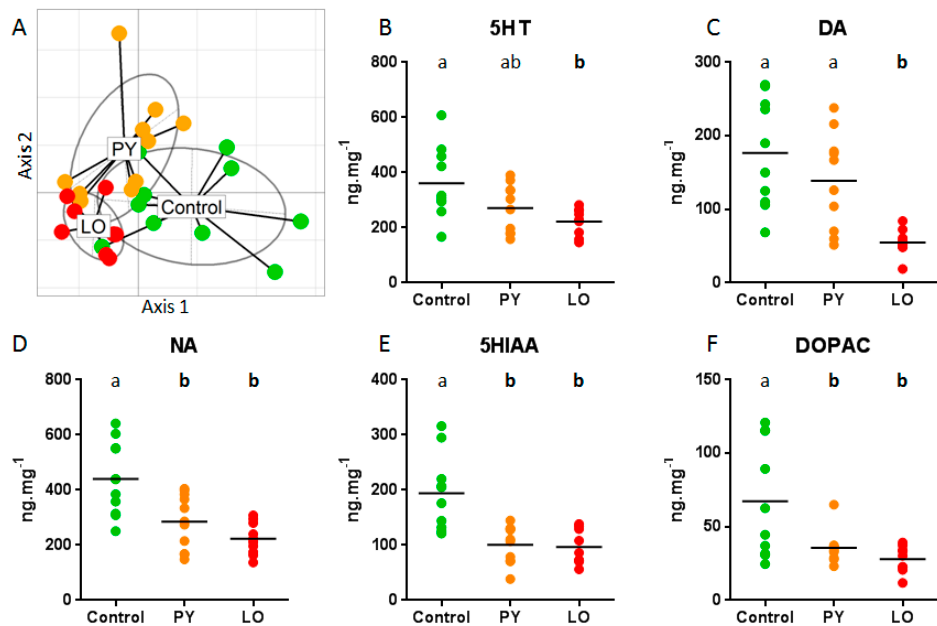
Figure 1. Analysis of monoamine brain content. ( A ) principal component analysis (PCA) global analysis of brain monoamine concentrations clearly identify pyrolytic (PY) and light crude oil (LO) as different from Control group. PCA axis 1 contributed to 82.1% of variability and PCA axis 2 for an additional 8.8%; ( B – F ) Detailed analysis of brain monoamines and metabolites concentrations in PY, LO and Control fish. Each dot represents results from an individual fish. Letters indicate significant differences at p < 0.05 between diets.